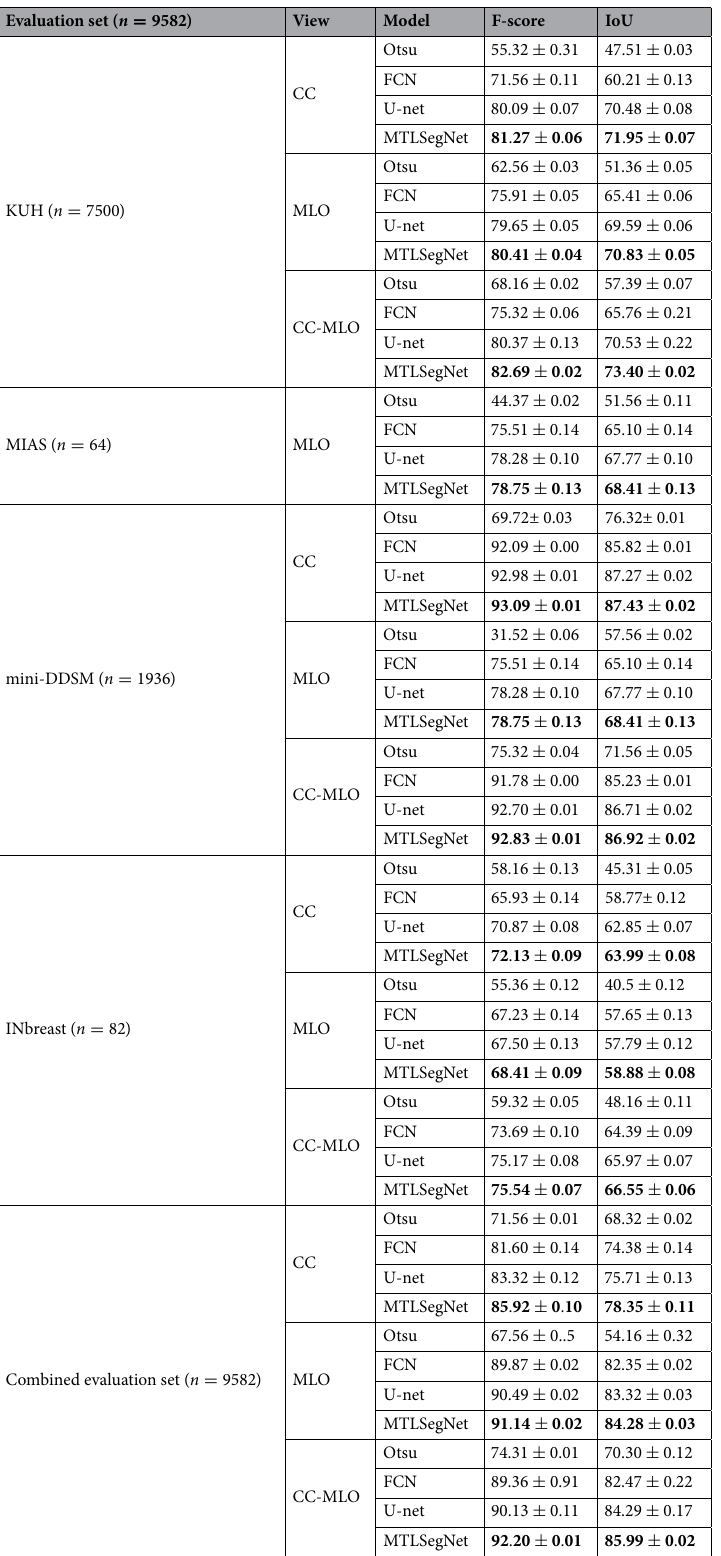
Table 4. The proposed MTLSegNet segmentation approach outperforms the FCN and U-net networks in all datasets. Numbers in parentheses denote the number of evaluation data points in each dataset. We compare the performance of MTLSegNet on the individual validation datasets for CC-, MLO-, and CC-MLO-view mammograms in terms of F-score and IoU, as evaluation metrics. Best values are in